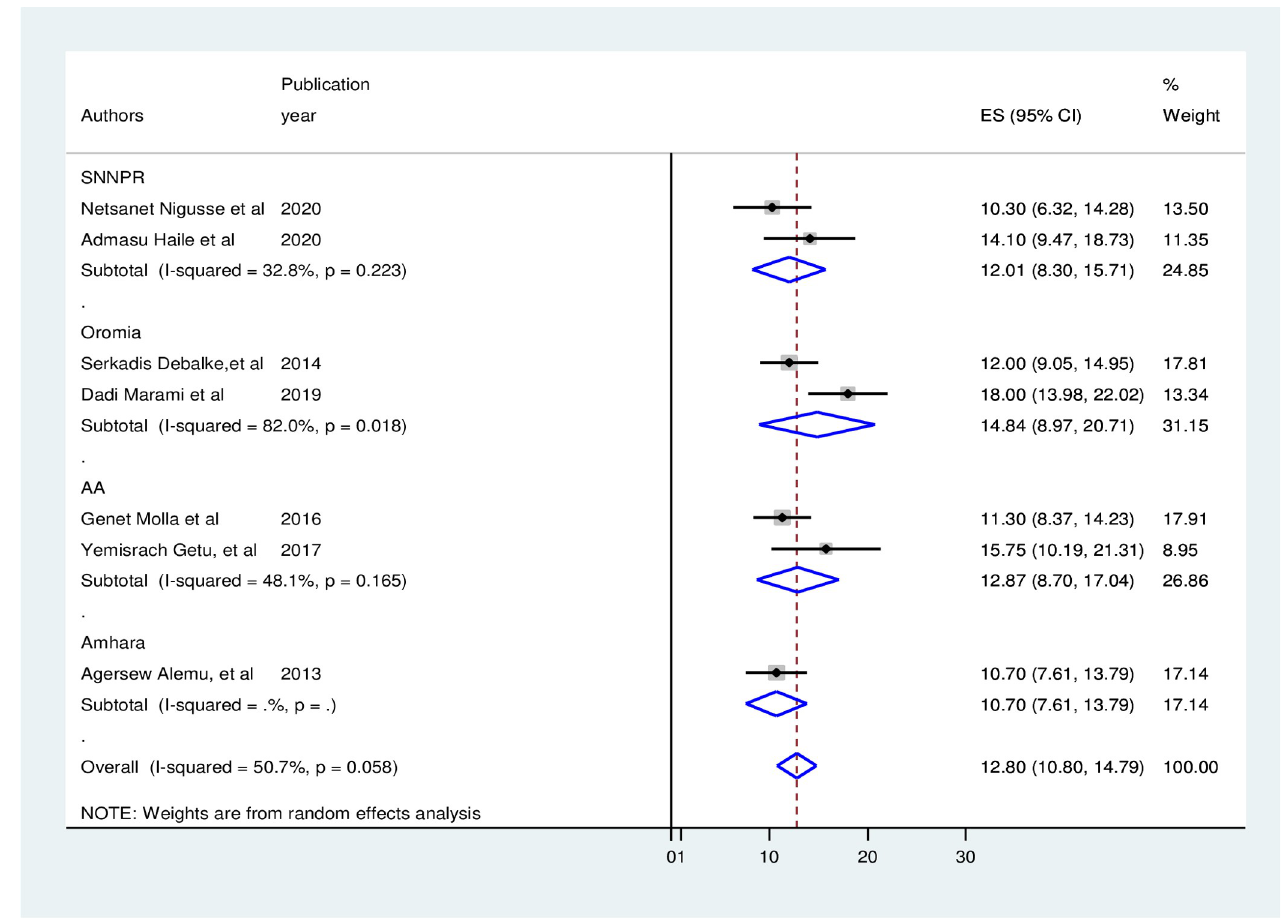
Fig 3. Subgroup analysis over